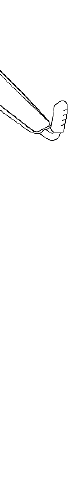
Figure 7. Sketch of the final choice.